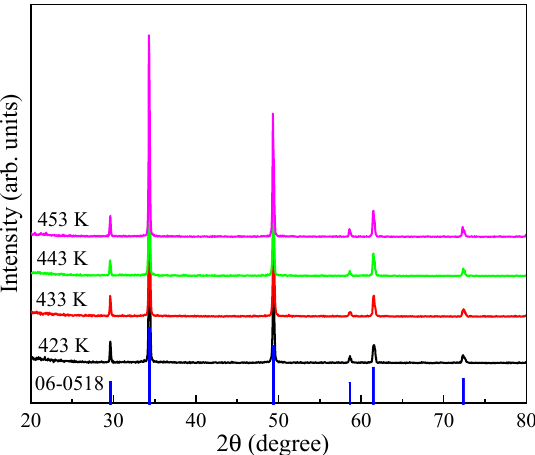
Figure 1. XRD patterns of MnS treated at different temperatures. UV-vis DRS results (Figures 3A and S3) indicated that MnS exhibited the strong visible-light response, which was slightly affected by the hydrothermal temperature and time. Based on the linearized Kubelka–Munk equation, the estimated band-gap energy (Eg) values of MnS were also mildly influenced by the hydrothermal temperature and time (Table S1) [55,59]. Notably, the Eg value of α -MnS treated at 433 K for 16 h was 1.37 eV. Among these MnS samples treated at various temperatures, the MnS obtained at 433 K presented the strongest photocurrent (Figure 3B). However, the photocurrent intensities of MnS samples decreased with the increasing radiation time. It is indicated that the photo-induced holes and electrons of MnS are likely to recombine in the irradiation process [47,60]. Due to the unique octahedral structure of MnS, the photoinduced electron- hole pairs are efficiently at the edge sites and the coarse plane of MnS, the combination of photo-generated electron-hole pairs could be efficiently restrained [33,34]. The smallest radius of electrochemical impedance spectra (Figure 3C) was obtained by MnS treated at 433 K for 16 h, meaning the highest efficiency of charge carveries transfer and the lowest resistance of surface layer [22,25]. Considering the flat-band potentials (EFB) close to the Fermi level (Ef) (Figures 3D and S4), the EFB values of MnS samples estimated by the Mott-Schottky equation ranged from − 0.778 to − 0.974 V (Table S1). Hence, the calculated ECB and EVB of MnS treated at 433 K for 16 h were − 0.58 and 0.79 eV, respectively. For MnS treated at 433 K for 16 h, the split peaks of Mn 2p at 652.99 and 641.31 eV were respectively ascribed to Mn 2p1/2 and Mn 2p3/2 of Mn 2+ , and their corresponding satellite peaks located at 655.29 and 644.39 eV (Figure 4A) [33,59]. The dissected peaks of S 2p at 161.53 and 160.33 eV (Figure 4B) were ascribed to S 2p1/2 and S 2p3/2, respectively. However, the tested atomic ratio of Mn/S was lower than 1:1, indicating the formation of S defects in octahedral MnS. The Zeta potential plots (Figure S5) indicated that the pH range of 3.00~9.36 and 10.75~11.00 induced to the negative surface discharge of MnS treated at 433 K for 16 h, while the pH range of 9.36~10.75 resulted in the positive surface discharge. Previous works [60,61] reported that TCH had three species, including cationic (TCH 3+ ) at pH < 3.3, zwitterionic at pH of 3.3~7.7, and anionic (TCH − and TC 2 − ) at pH > 7.7, respectively. Hence, the obtained MnS could efficiently adsorb TCH at pH of 3.3~10.75 via the electrostatic attraction, maximizing the adsorption efficiency of TCH [27,38]. PL spectra (Figure 5) suggested that the PL intensity of MnS decreased and then increased with an increase in hydrothermal temperature. For comparison, MnS treated at 433 K exhibited the lowest PL intensity, meaning the efficient transfer and separation of charge